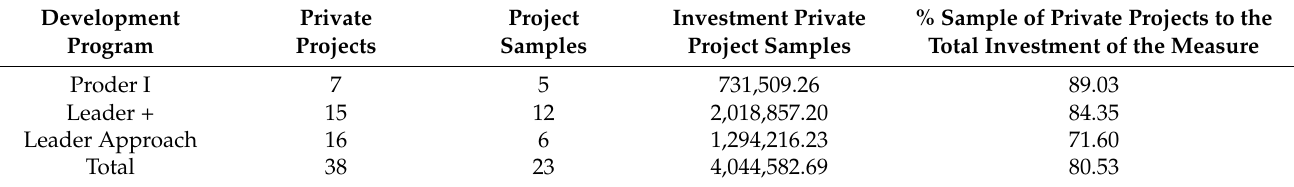
Table 3. Sample of private tourism projects in the Tajo-Salor